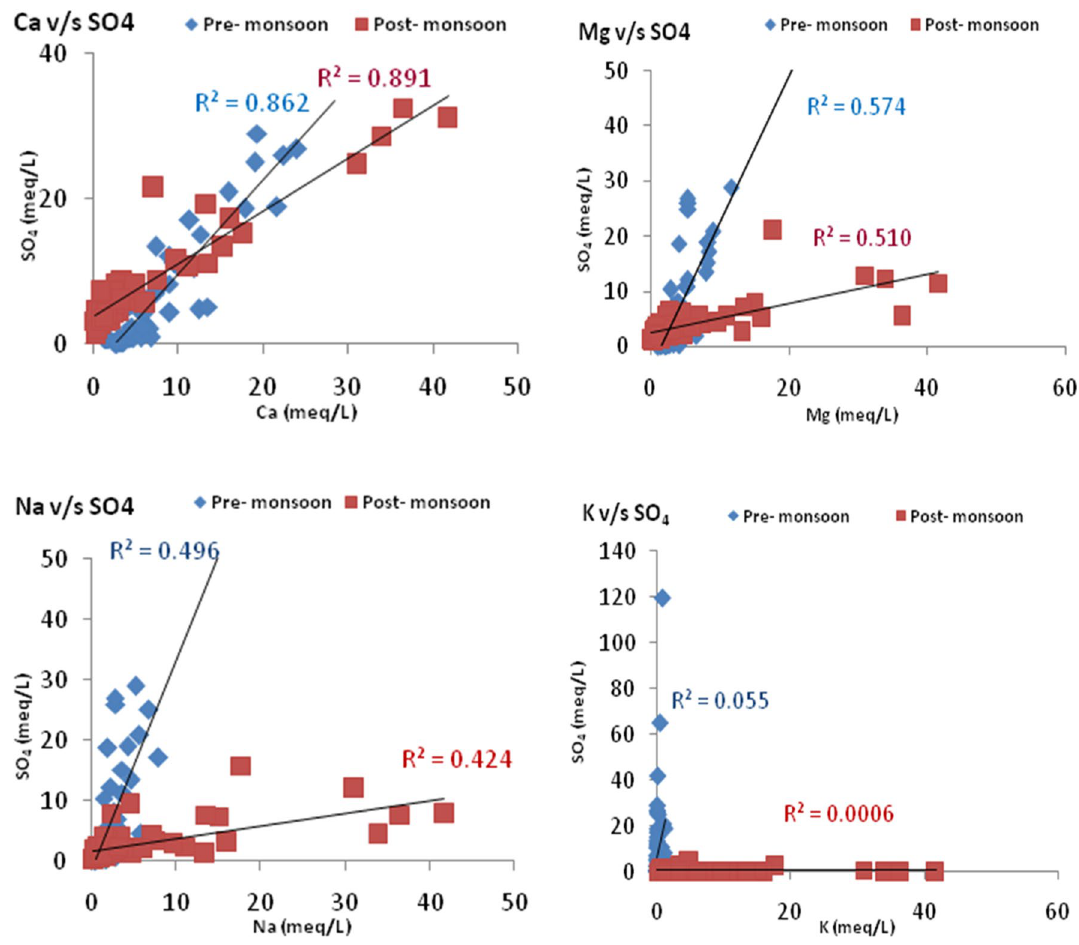
Fig. 10 Plots of SO 42− against Ca 2+ , Mg 2+ , Na + and K +